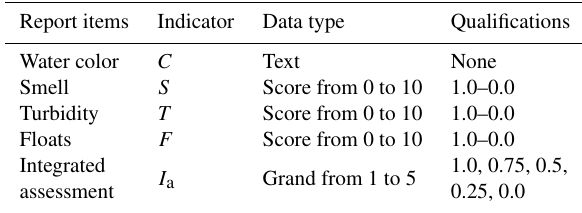
Table 1. Normalization of